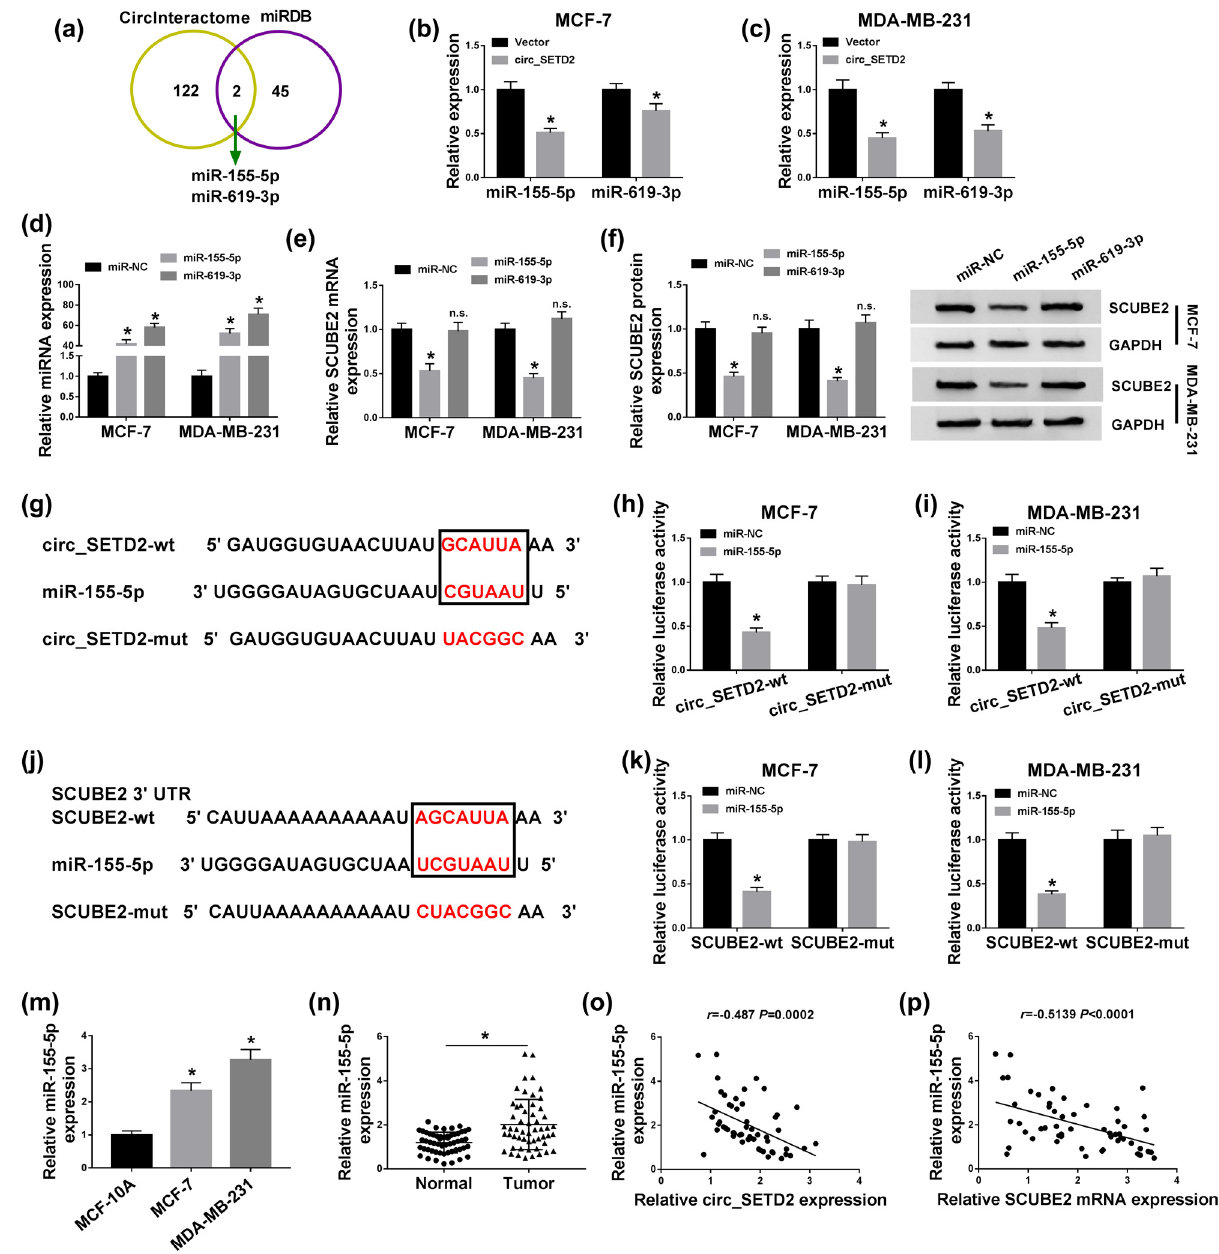
Figure 4: miR - 155 - 5p and SCUBE2 served as a target for circ_SETD2 or miR - 155 - 5p in BC cells. ( a ) The relationship between circ_SETD2 or SCUBE2 and miR - 155p - 5p or miR - 619 - 3p was predicted using the CircInteractome or miRDB database. ( b and c ) E ff ect of circ_SETD2 overexpression on miR - 155 - 5p or miR - 619 - 3p expression in MCF - 7 and MDA - MB - 231 cells was determined by qRT - PCR. ( d ) The transfection e ffi ciency of miR - 155 - 5p or miR - 619 - 3p in MCF - 7 and MDA - MB - 231 cells was assessed by qRT - PCR. ( e and f ) The impacts of miR - 155 - 5p or miR - 619 - 3p enhancement on the expression of SCUBE2 mRNA and protein were evaluated by qRT - PCR or western blot analysis. ( g ) The binding sites of miR - 155 - 5p in circ_SETD2. ( h and i ) Dual luciferase reporter assay was executed to assess the luciferase intensity of the circ_SETD2 - wt or circ_SETD2 - mut reporter vectors in MCF - 7 and MDA - MB - 231 cells transfected with miR - 155 - 5p or miR - NC. ( j ) The binding sites of SCUBE2 in miR - 155 - 5p. ( k and l ) Dual luciferase reporter assay was carried out to determine the luciferase activity of the SCUBE2 - wt or SCUBE2 - mut reporter vectors in MCF - 7 and MDA - MB - 231 cells transfected with miR - 155 - 5p or miR - NC. ( m and n ) The expression of miR - 155 - 5p in BC cells ( MCF - 7 and MDA - MB - 231 ) and tissues was examined by qRT - PCR. ( o and p ) The correlation between miR - 155 - 5p and circ_SETD2 or SCUBE2 in BC tissues was determined by Pearson ’ s correlation analysis. The data are presented as mean ± standard deviation; paired Student ’ s t test was utilized to compare the di ff erences between BC tissues and adjacent normal tissues; one - way ANOVA followed by Tukey ’ s post hoc test was utilized to compare the di ff erences among groups; the experiments were repeated three times. * P <